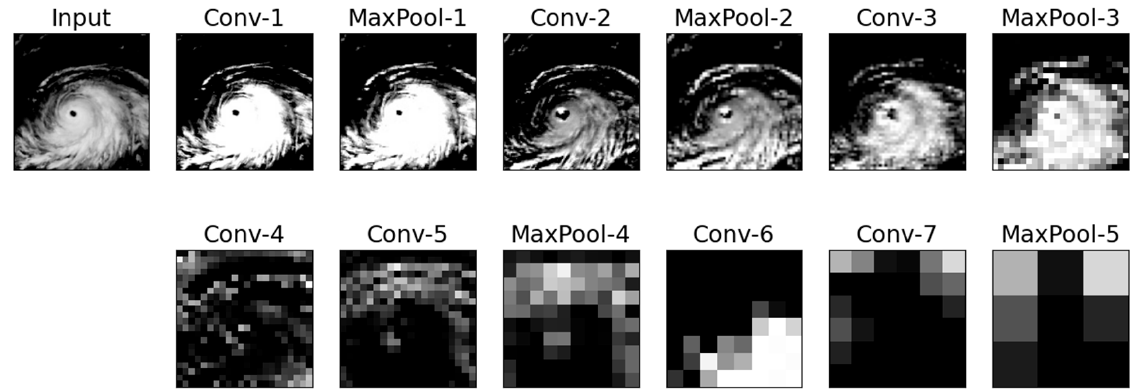
Figure 8. Learned abstract features after subsampling in the TICAENet model.